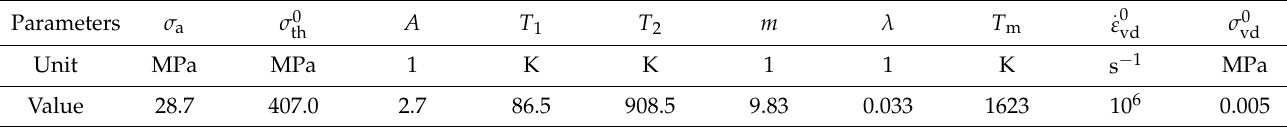
Table 10. Parameters of the TBRI model for A508 steel [20].